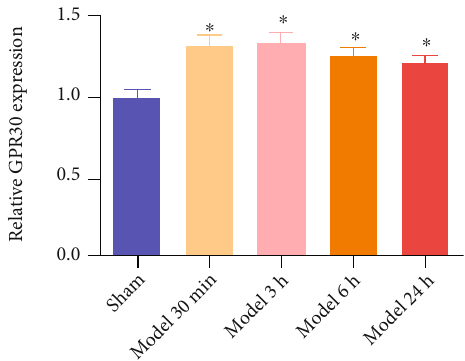
Figure 2: BCAS modeling promoted the expression of hippocampal GPR30. GPR30 mRNA expression was promoted 30min, 3h, 6h, and 24h in the hippocampus after BCAS. ∗ P < 0 : 05 , vs. sham ( N = 5 in each